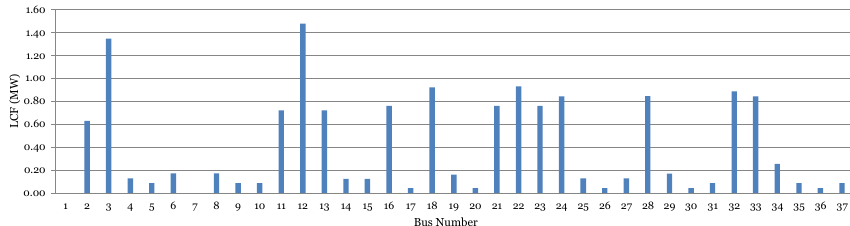
Figure 1. Load concentration factors for 37 node system.